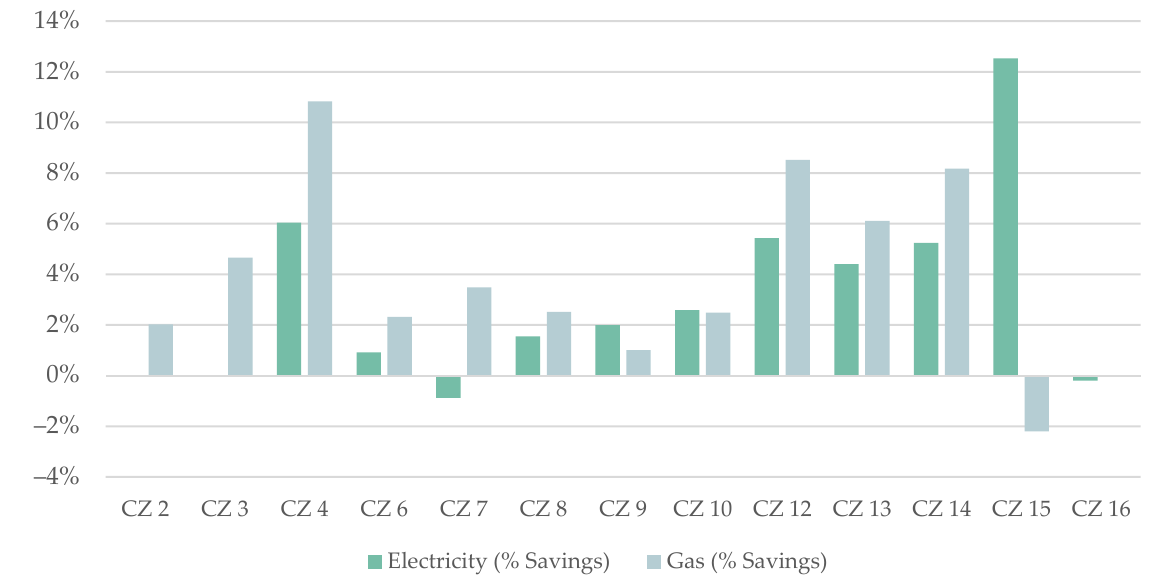
Figure 3. Energy efficiency project impacts by California climate zone. Note: We do not include results in climate zones where we had results for less than 100 households for a given fuel. This includes climate zones 2 and 3 for electricity, and climate zone 16 for gas. Climate zone 1 did not have enough households with results for either fuel.